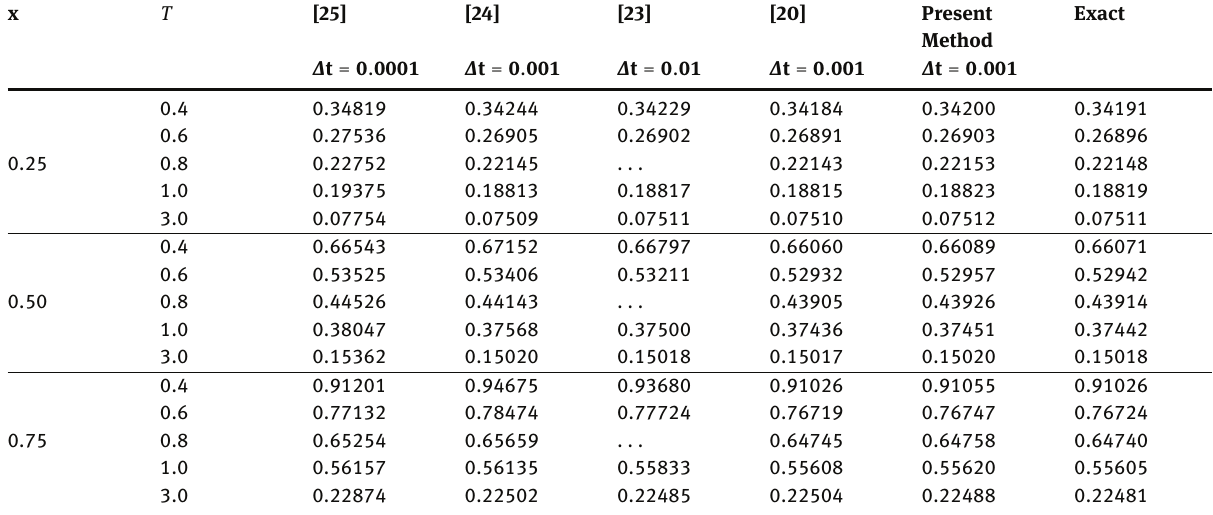
Table 4: Comparison between exact and existing numerical solutions of Example 1 for ν = 0.01 at different times T and x